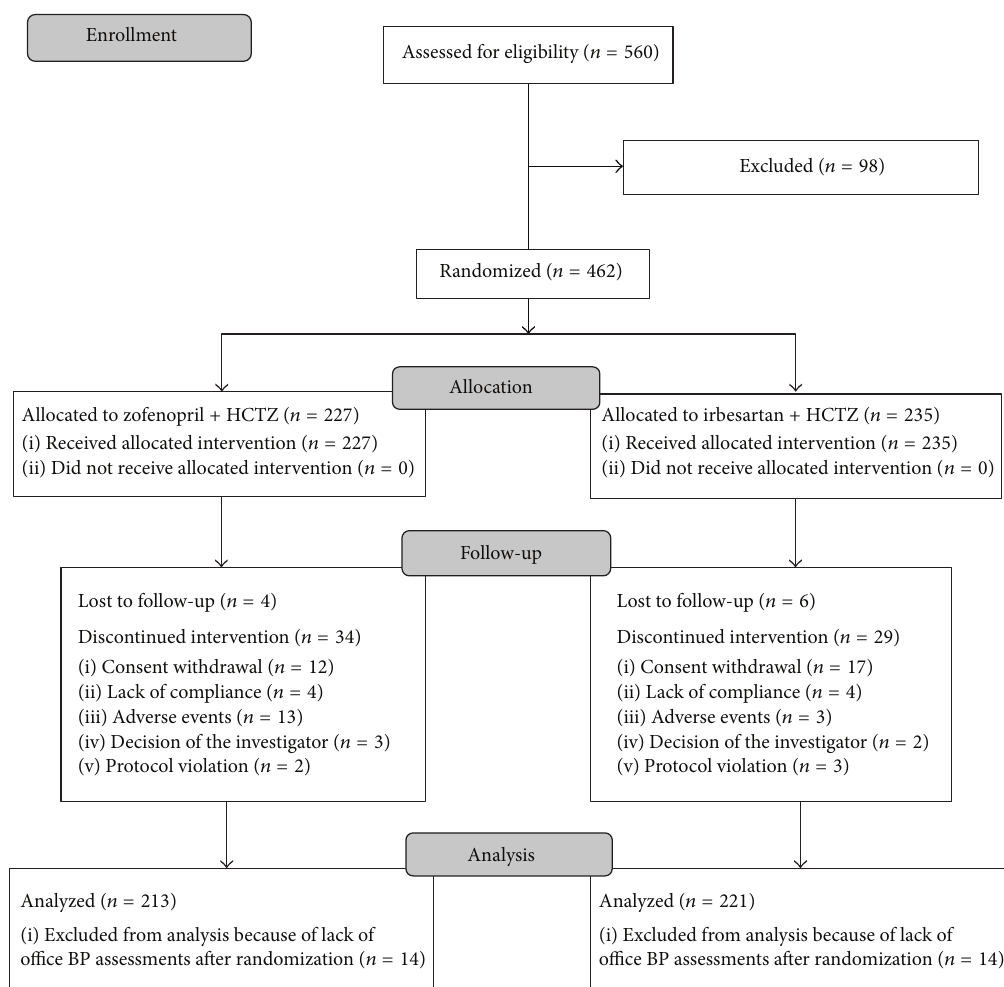
Figure 1: Flow diagram of the patients through the different phases of the